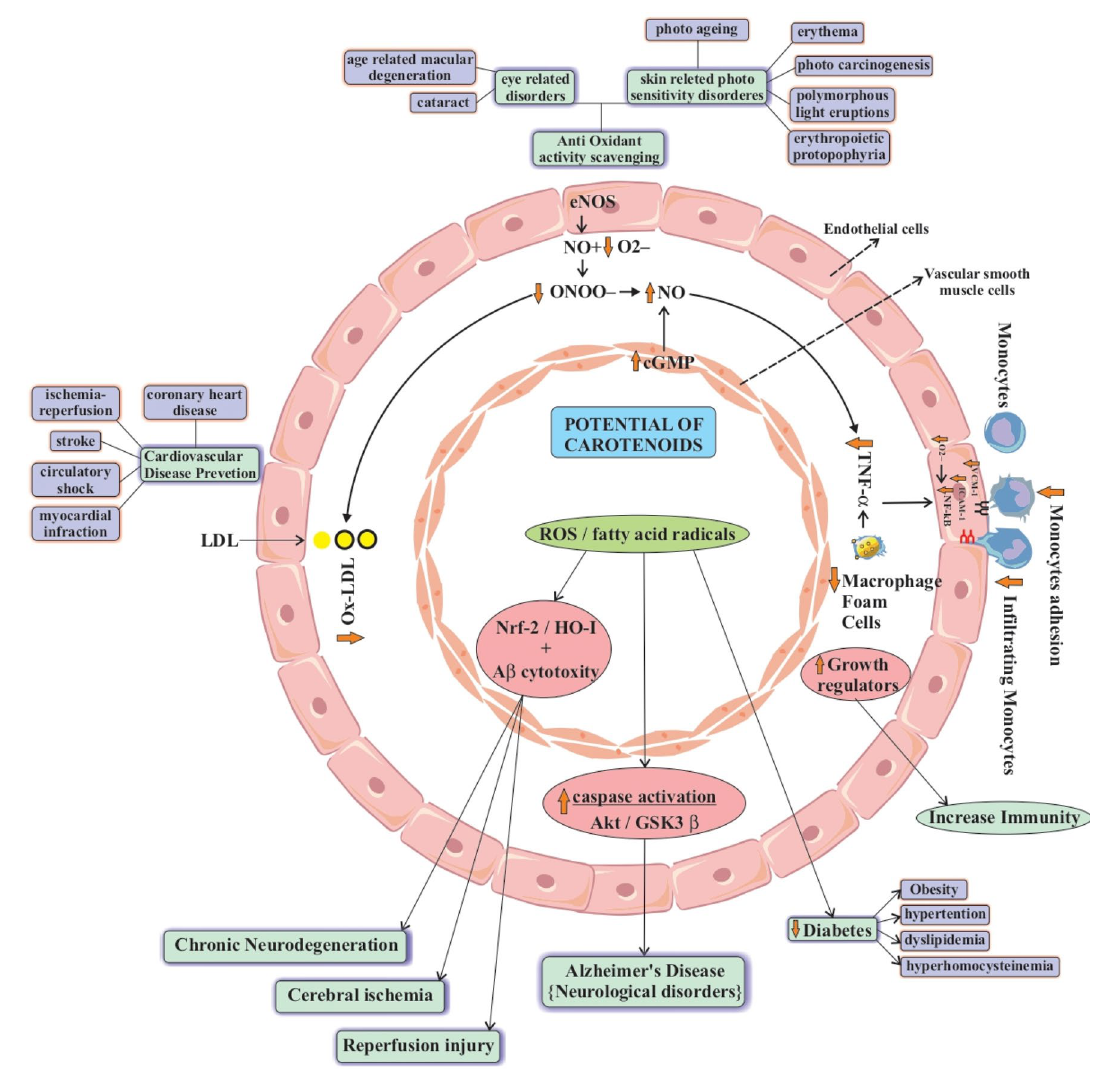
Fig. 2 Potential of carotenoids to prevent diseases [18,